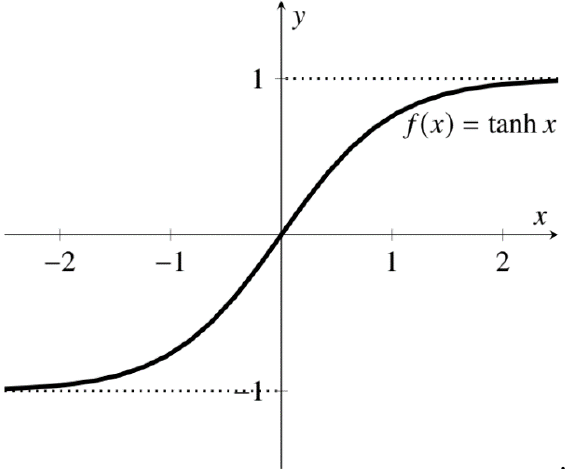
Figure 5. Output function of neurons shape of hyperbolic tangent tanh x.